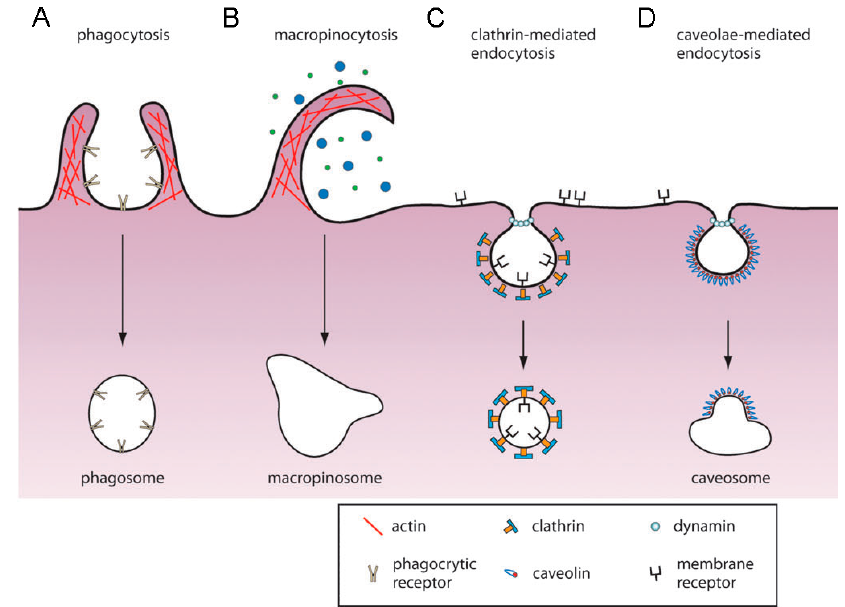
Figure 3. Uptake mechanisms of mammalian cells: ( A ) phagocytosis, (B ) macropinocytosis, ( C ) clathrin-mediated endocytosis and ( D ) caveolae-mediated endocytosis. See text for more details. (Reproduced from Reference [32] with permission from The Royal Society of Chemistry).